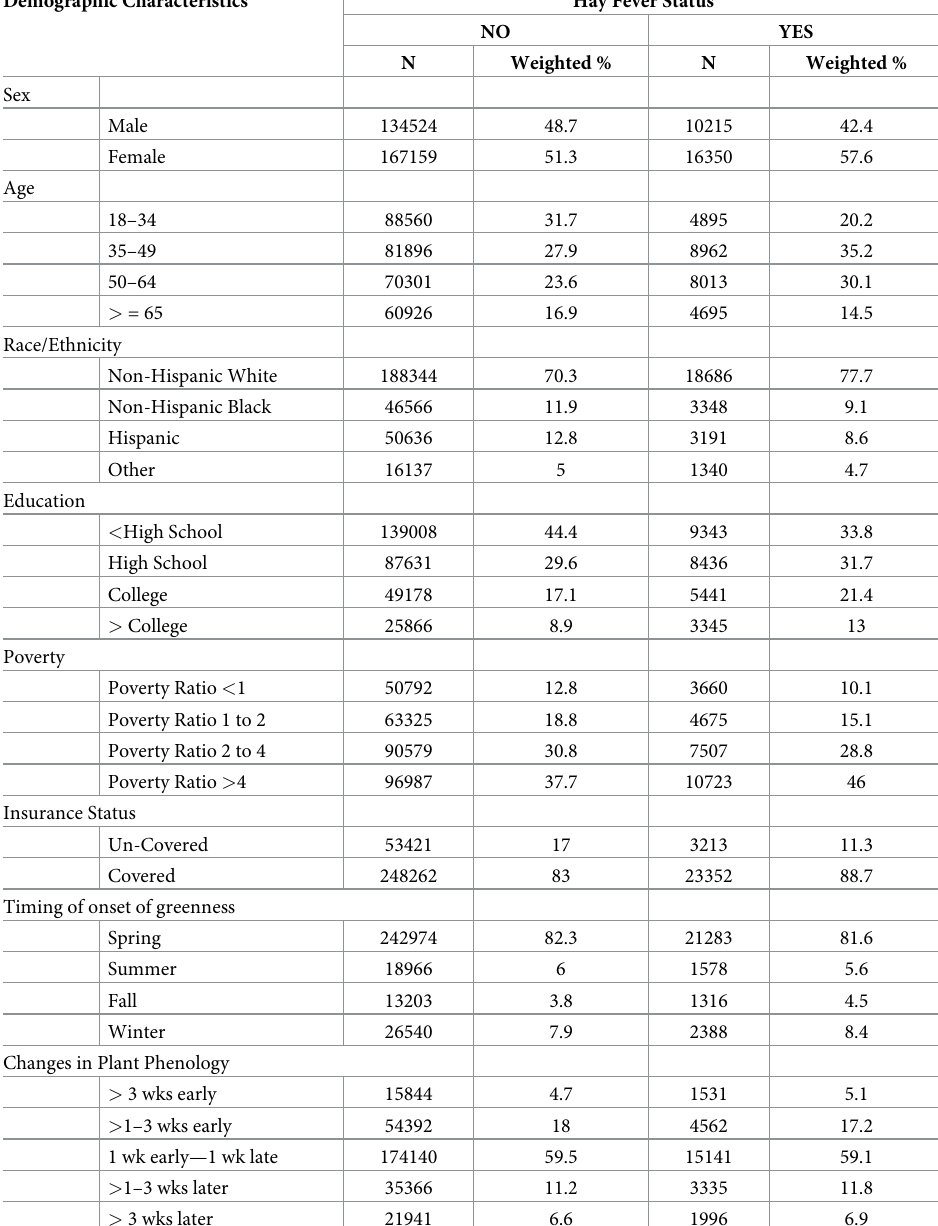
Table 1. Demographic characteristics of the NHIS Respondents: